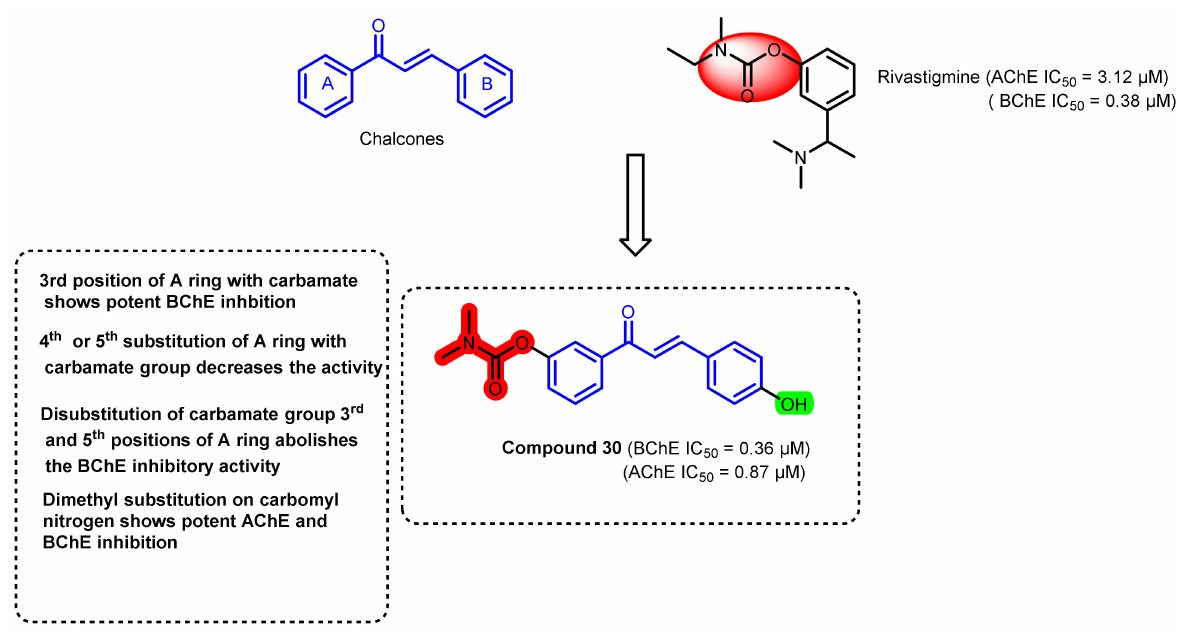
Figure 27. Chemical structures of rivastigmine–chalcone hybrid